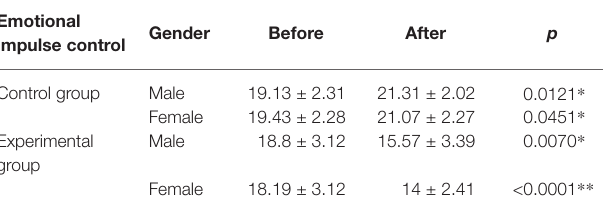
TABLE 5 | Gender differences of GIMT effect in emotional impulse control. Emotional impulse control